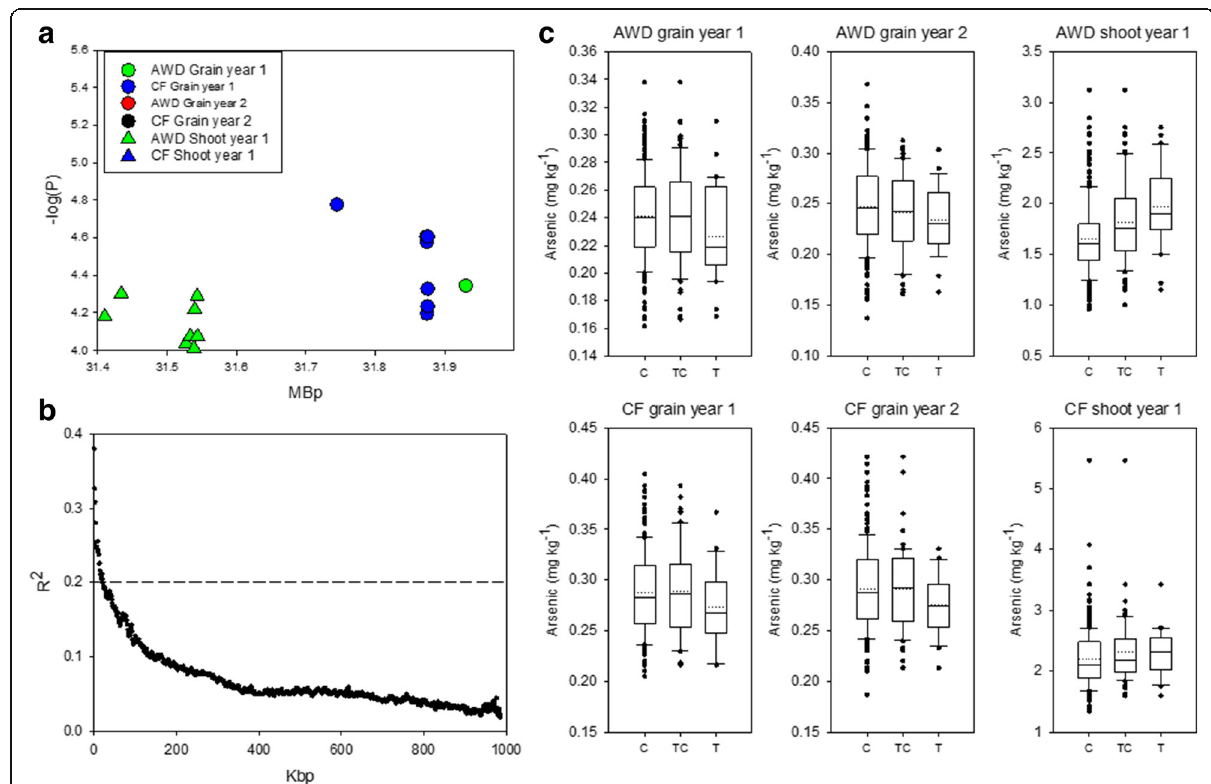
Fig. 5 Significant associations for arsenic traits on chromosome 4 (31.4 – 32.0 Mb). a SNPs associated with the arsenic phenotypes. b Determination of local R 2 on chromosome 4 from 31.0 – 32.0 Mb. c Range of phenotypic variation observed for each allele across each trait